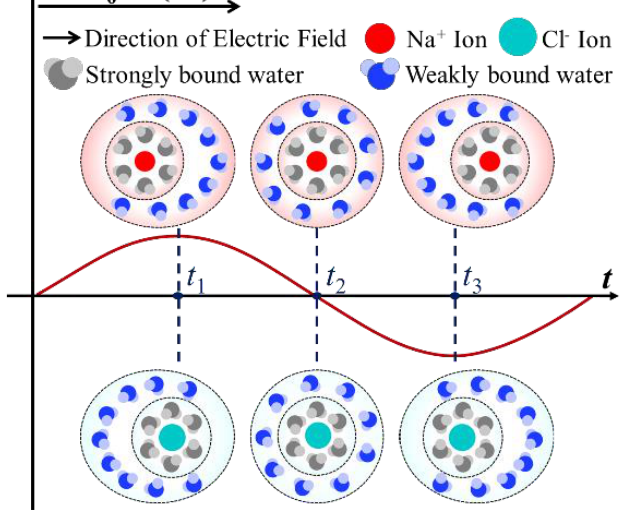
Figure 6. Induced dipoles of hydrated ions under an AC electric field.